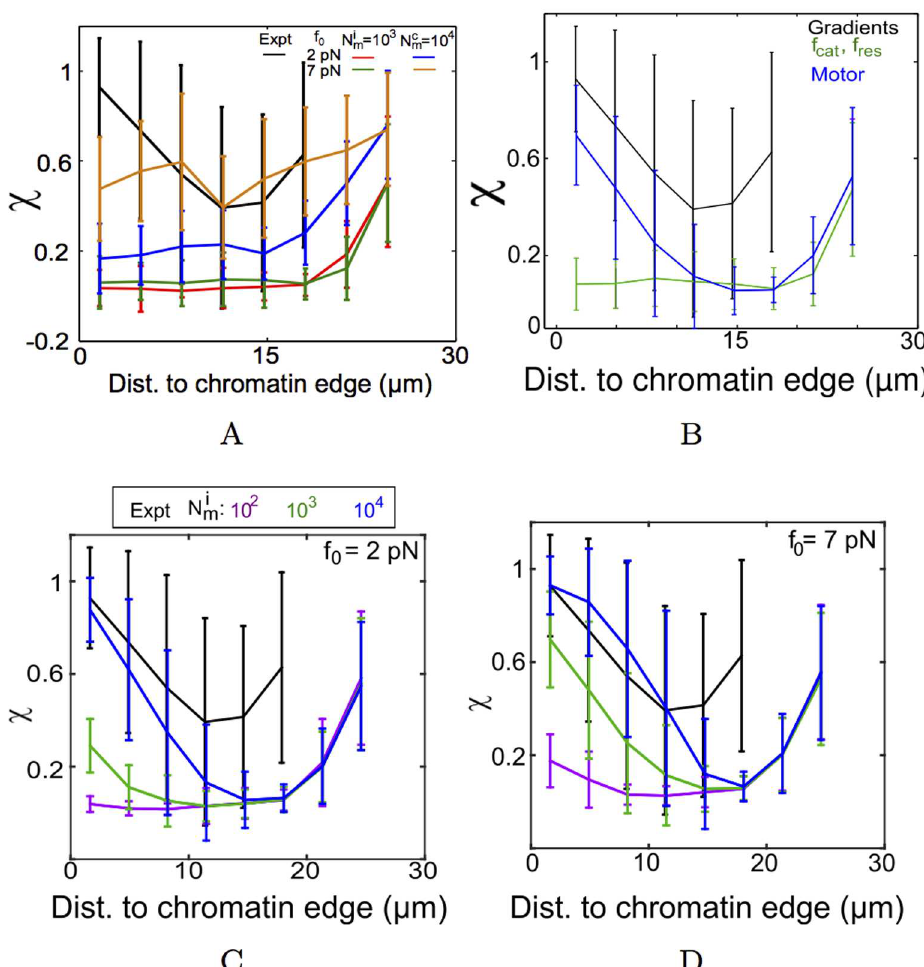
Fig 4. Directionality of simulated MTOCs compared to experiment. The distance dependence of binned directionality ( χ ) from experiment (black line) is comparedto multiple simulated scenarios. (A) Uniformly distributed motors which are either immobilizedweak ( f 0 = 2 pN) (red) or strong ( f 0 = 7 pN) (green) dynein-like ¼ 10 3 motors/oocyte are compared to tetrameric diffusible minus-enddirected dynein like motors with N i m ¼ 10 4 motors/oocyte. (B) The χ motor complexes with f 0 = 2 pN (blue) and f 0 = 7 pN (orange), with N c m ¼ 10 3 resulting from a gradientof f cat and f res (green) is compared to a gradientof the immobilizedmotors ( N i m motors/oocyte, f 0 = 7 pN) (blue). In a gradient of immobilized motors with (C) f 0 = 2 pN and (D) f 0 = 7 pN the ¼ 10 2 (purple), 10 3 (green) and 10 4 radial distributionof χ is plotted for increasingmotor densities: N i m motors/oocyte (blue). All values of χ are mean ± s.d. Simulations were averagedfrom 10 runs with 80 MTOCs